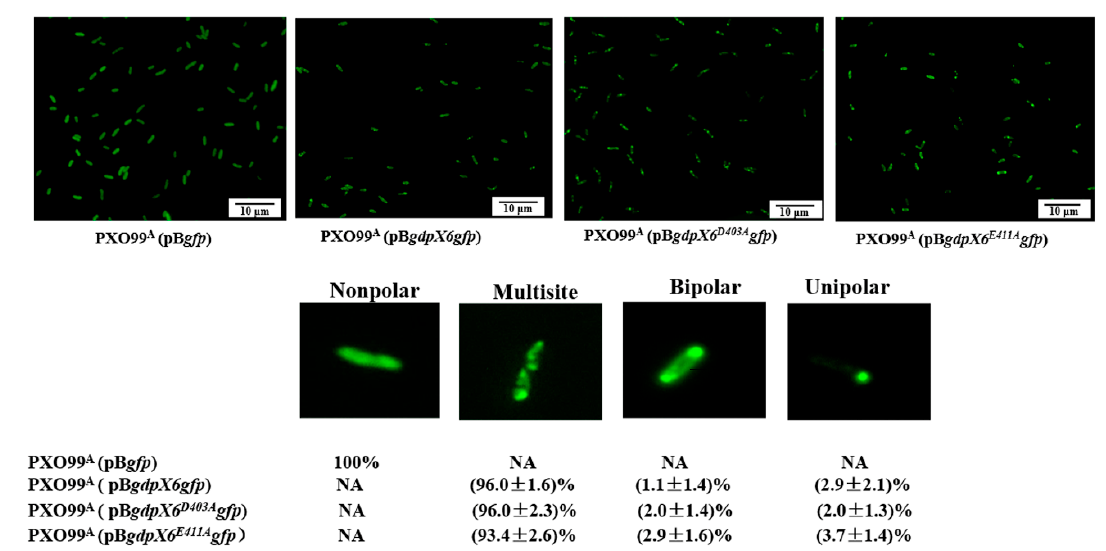
Figure 7. Subcellular localization of GdpX6 in Xoo PXO99 A . PXO99 A (pB gfp ), PXO99 A (pB gdpX6gfp ), PXO99 A (pB gdpX6 D403A gfp ) and PXO99 A (pB gdpX6 E411A gfp ) were grown in M210 to an OD 600 of 1.0. Photograph of the GFP fusion protein in PXO99 A detected using a fluorescence microscope (Olympus BX61). Different subcellular locations of proteins GdpX6 ‐ GFP, GdpX6 D403A ‐ GFP, and GdpX6 E411A ‐ GFP including nonpolar, bipolar, multisite were calculated the proportion were counted. ± indicates the standard deviations from three biology repeats. NA, not available.